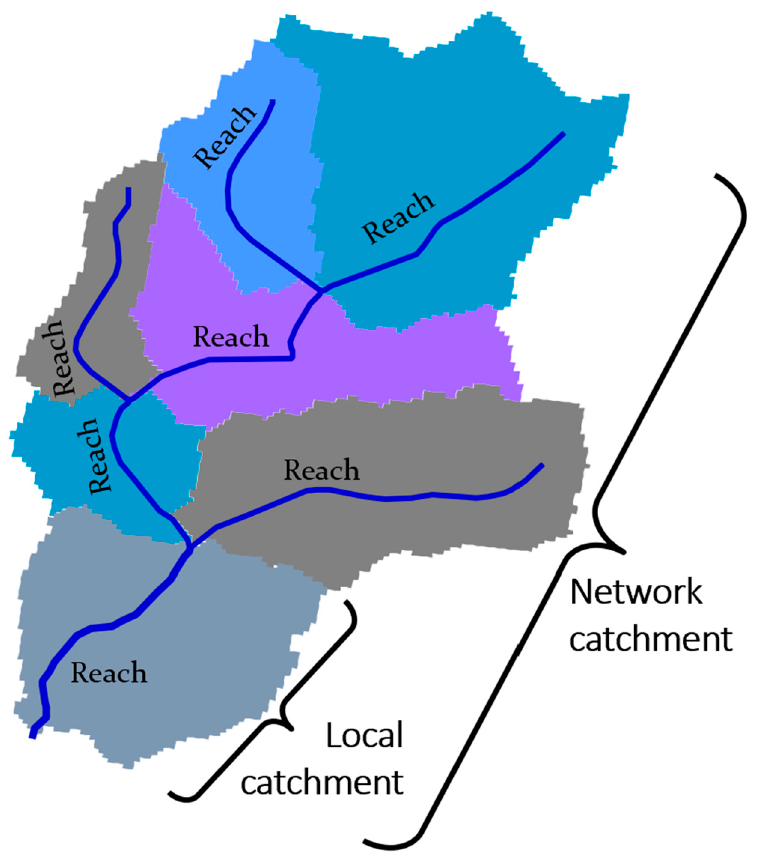
Figure 2. Stream reaches and the local and network catchments of the reaches. For assessing natural characteristics and human disturbances, data on natural and human-disturbance variables are attributed to each spatial unit (i.e., river segment) of the USHFD database. The variables describing values of natural variation in climate, eleva- tion, geology, soil, land cover, groundwater contribution, and river connectivity represent surrogates of river segment-scale natural variation in physicochemical and biological char- acteristics. Some of the natural variation descriptors, such as network catchment size, Strahler order, segment length, mean elevation, and gradient, are calculated or obtained from the NHDPlusV1 database. The other natural descriptors, such as mean annual air tem- perature and precipitation, soil permeability, types of surficial geology, and